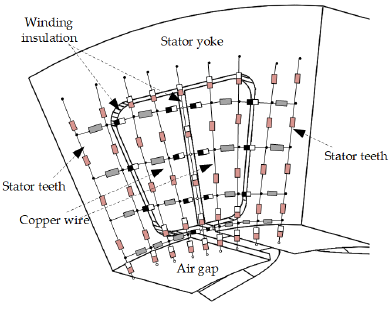
Figure 5. The thermal network model of DHEG stator part.